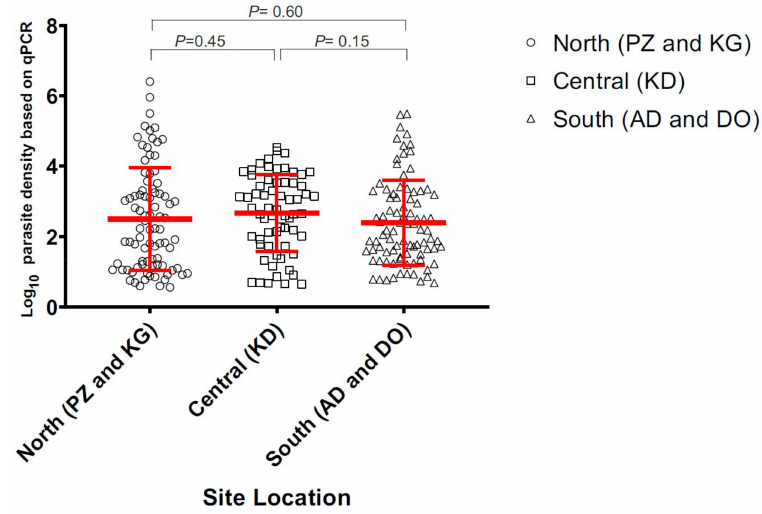
Figure 2. Estimated parasite density of samples collected in the north, central, and south of